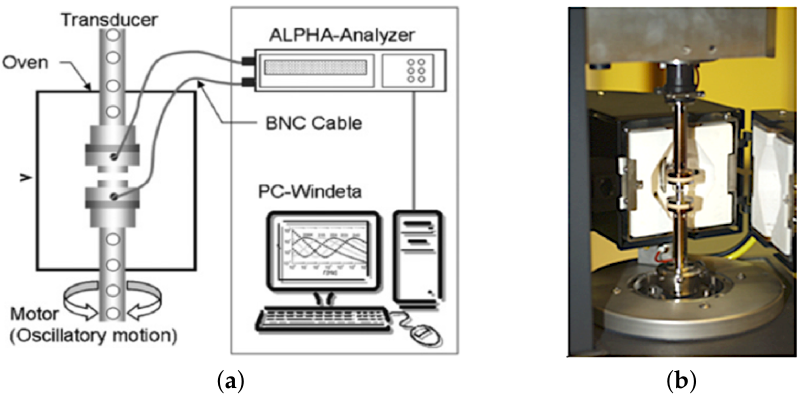
Figure 4. Simultaneous rheo-dielectric measurements performed to characterize the EBA nanocomposites. ( a ) Diagram of the combined rheometer and dielectric analyzer for determining the raw stress data and the dielectric spectra in situ. ( b ) Image of the rheo-dielectric